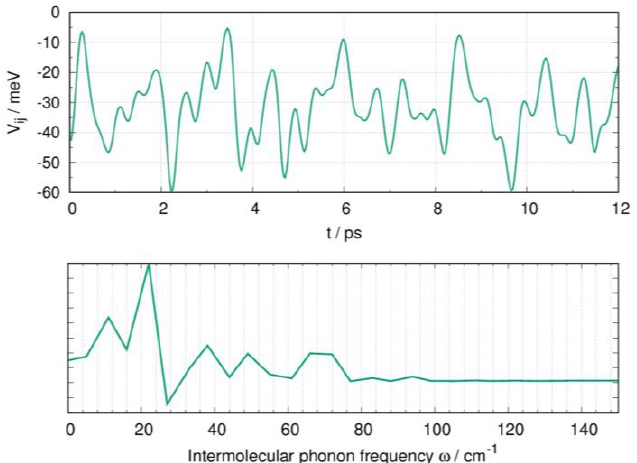
Figure 7. Dynamic disorder effects on the crystal of N-NDTI from MD simulations, showing ( top ) the fluctuations of transfer integrals V ij for the P1 charge transfer path, computed from snapshots of MD at 300 K and ( bottom ) a Fourier transform of the autocorrelation function of the transfer integrals, showing the activity of low-frequency intermolecular phonons.